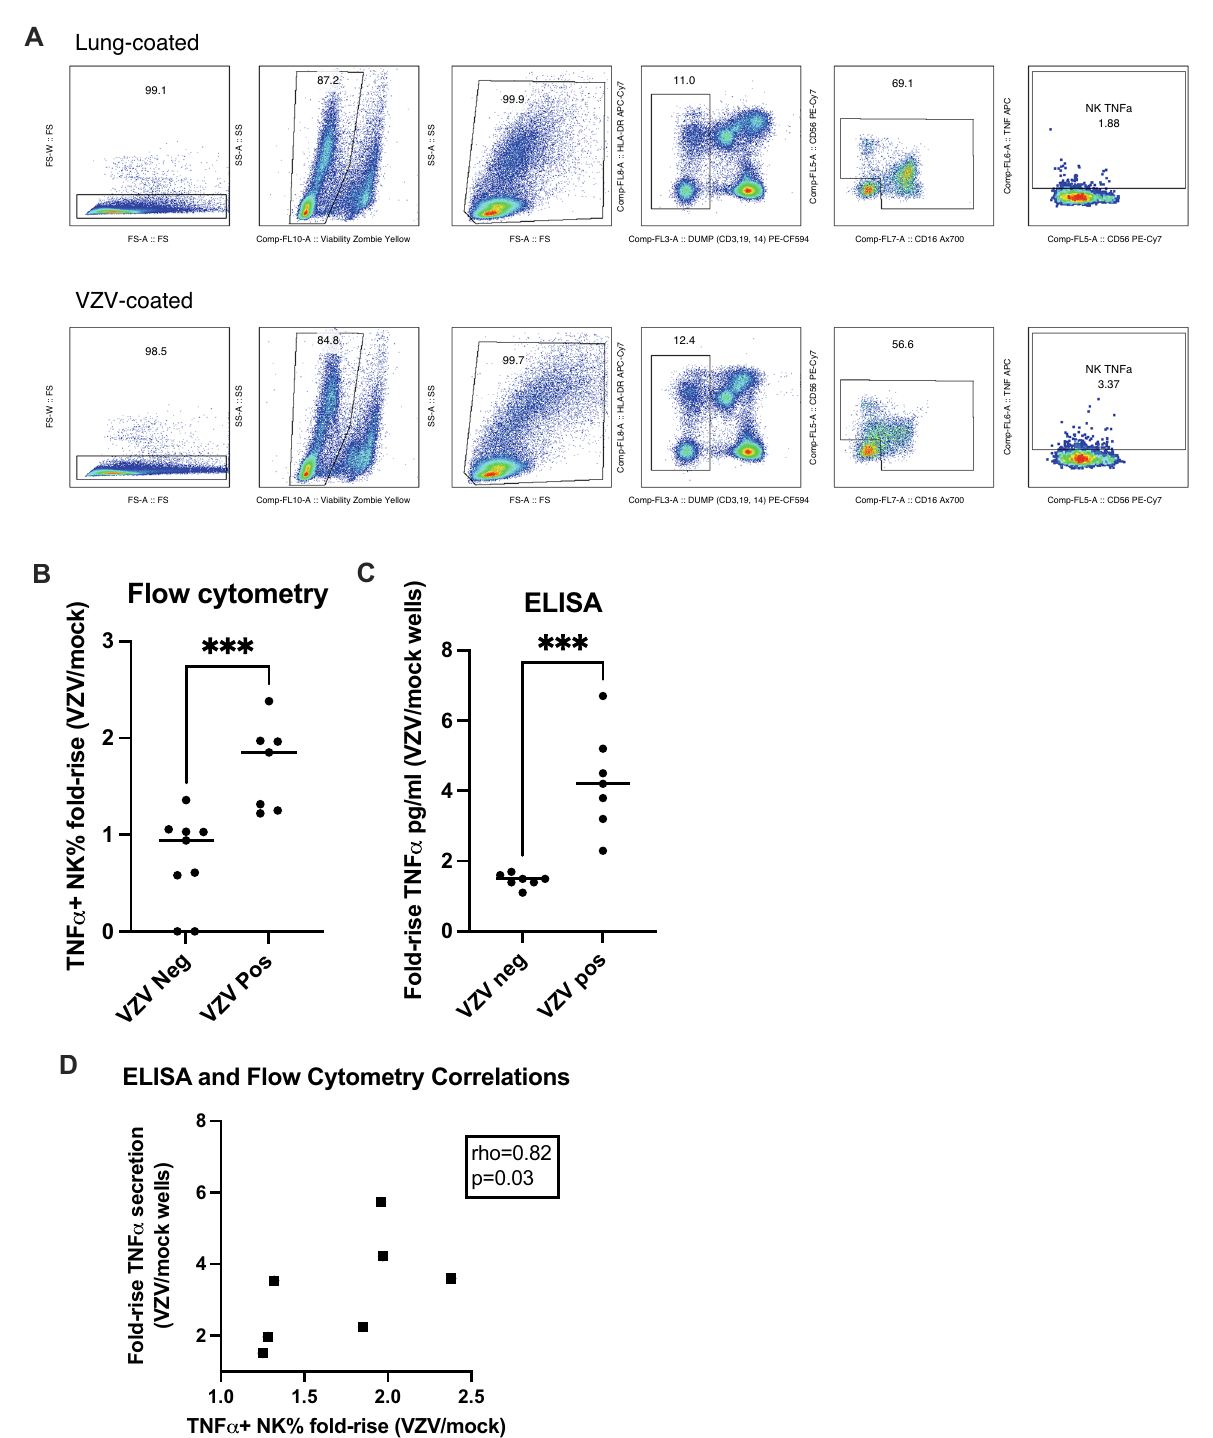
Fig. 1 VZV-Speci fi c ADCC measured by the NK cell production of TNF α . Data were derived using 9 VZV-seronegative and 7 VZV- seropositive serum samples and PBMC from a single leukopack. A Gating strategy of the fl ow cytometry assay. B Flow cytometry results . Data points indicate the proportions of TNF α -secreting NK cells in wells coated with VZV antigen/wells coated with mock- infected control antigen. The horizontal lines indicate the means. *** indicate p = 0.001 by unpaired T test. C ELISA results . Data points represent the proportions of TNF α -secreting NK cells in wells coated with VZV antigen/wells coated with mock-infected control antigen. The horizontal lines represent the means. *** indicate p = 0.0002 by unpaired T test. D Correlation between fl ow cytometric and ELISA results in VZV-seropositive samples